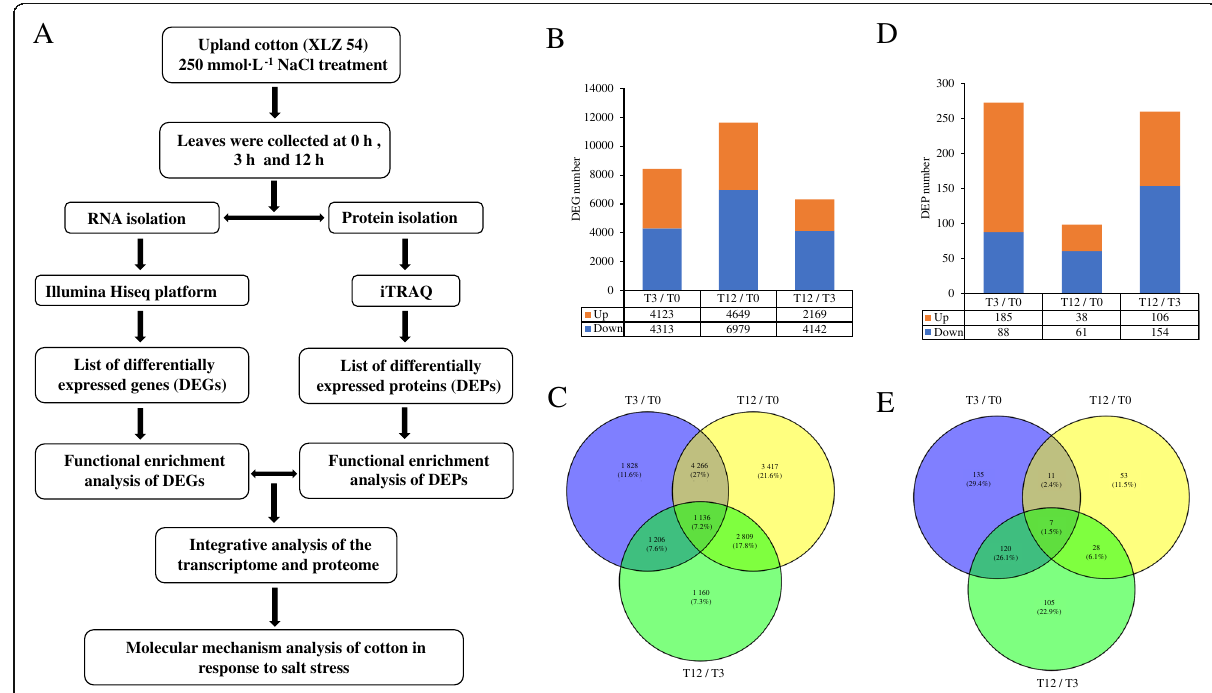
Fig. 1 Identification of differentially expressed genes (DEGs) and proteins (DEPs) in response to salt stress. a Scheme of experimental design in integrated transcriptome and proteome analysis. b Number of DEGs in different comparison groups. c Venn diagram of DEGs. d Number of DEPs in different comparison groups. e Venn diagram of